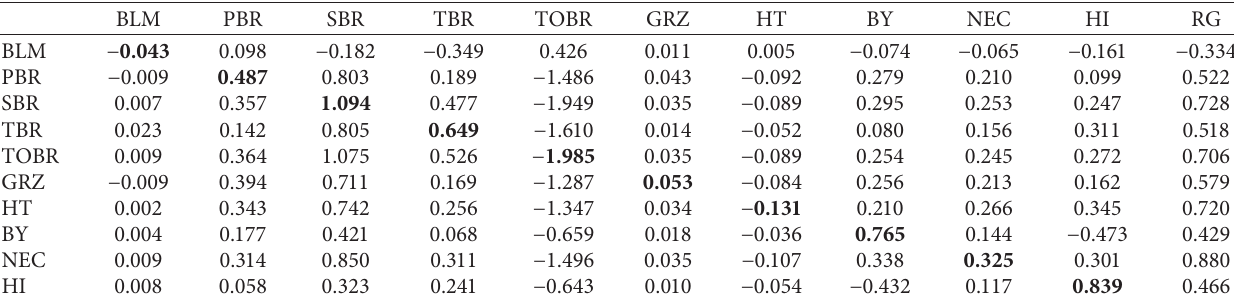
Table 4: Genotypic path analysis of the direct (bold) and indirect (off diagonal) effects of 16 traits on seed yield. BLM PBR SBR TBR TOBR GRZ HT BY NEC HI RG BLM − 0.043